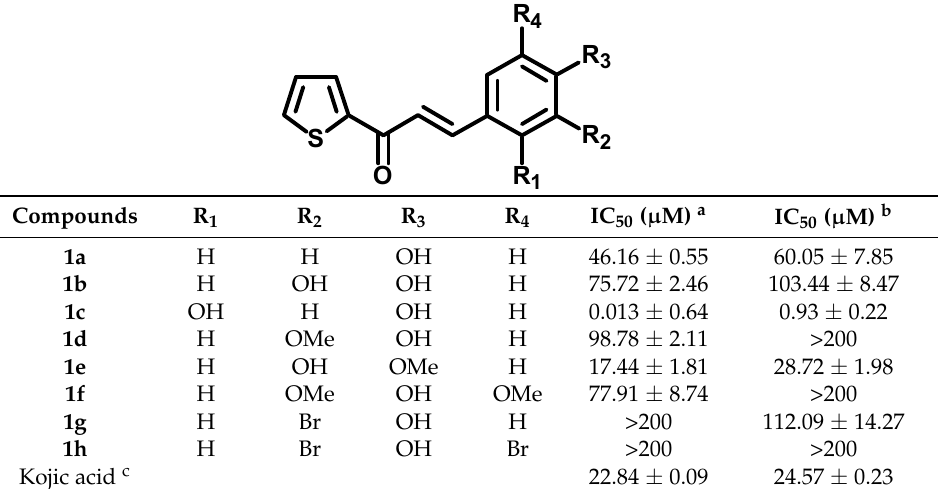
Table 1. Substitution pattern of the substituted 3-phenyl-1-thiophen-2-yl-propenone derivatives ( 1a – h ).